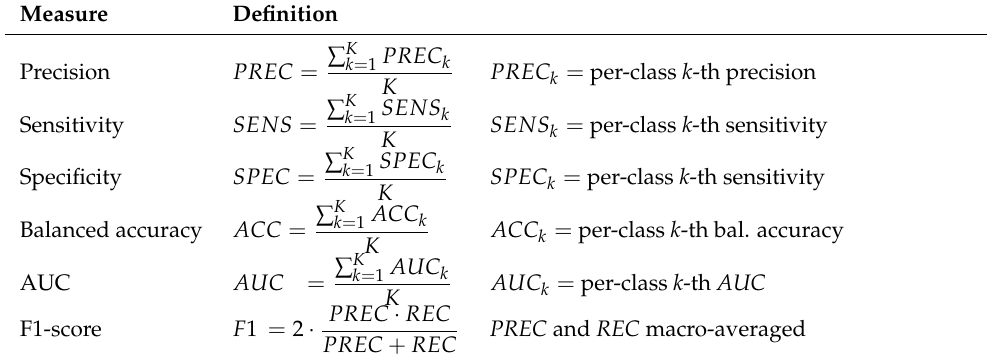
Table 4. Performance measure for multiclass classification.